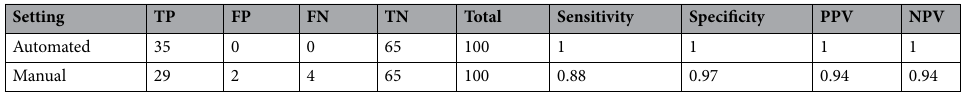
Table 2. Analysis for sensitivity and specificity comparing IVAC surveillance to the gold standard surveillance. TP True Positive; FP False Positive; FN False Negative; TN True Negative; IVAC Infectious Ventilator Associated